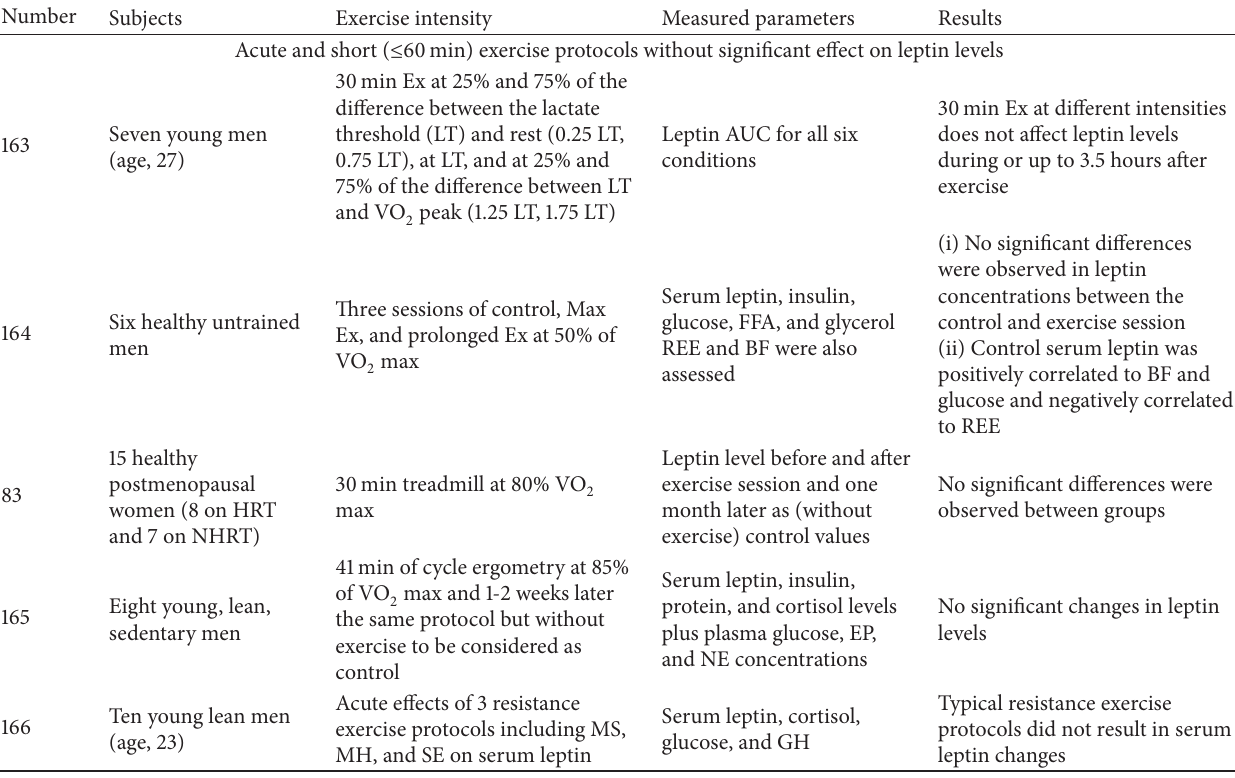
Table 2: Summary of selected clinical trials in which leptin levels were measured as a clinical outcome before and after exercise. Number Subjects Measured parameters